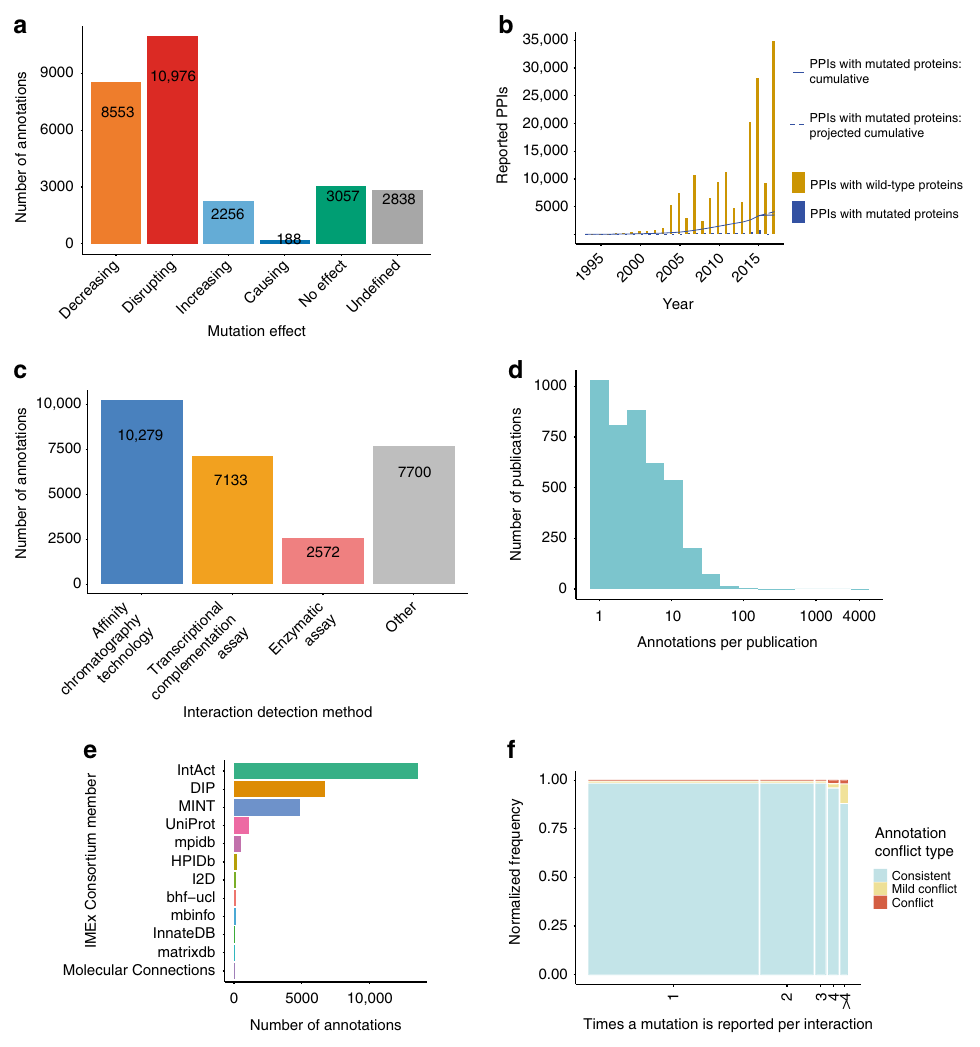
Fig. 1 IMEx mutations data set overview. a Number of annotations by effect type; b Increase of reported protein interactions involving wild type and mutated proteins over time. Bars represent total number of PPIs reported each year (wild type proteins in gold, mutated proteins in blue). Lines represent the cumulative sum of PPIs with mutated proteins, with the solid line representing the actual cumulative trend and the dashed line showing a projection for the last 3 years; c Distribution of the number of mutation annotations by interaction detection method; d Distribution of the number of mutation annotations captured per publication. The number of annotations per publication is shown on a log scale; e Number of mutation annotations per database of origin; f Internal consistency of repeatedly reported mutations. ‘ Con fl ict ’ cases are those in which the effects reported are antagonistic (e.g. ‘ disrupting ’ vs ‘ increasing ’ ). ‘ Mild con fl ict ’ cases are those in which the mutation is sometimes reported as having some effect vs others in which there is no